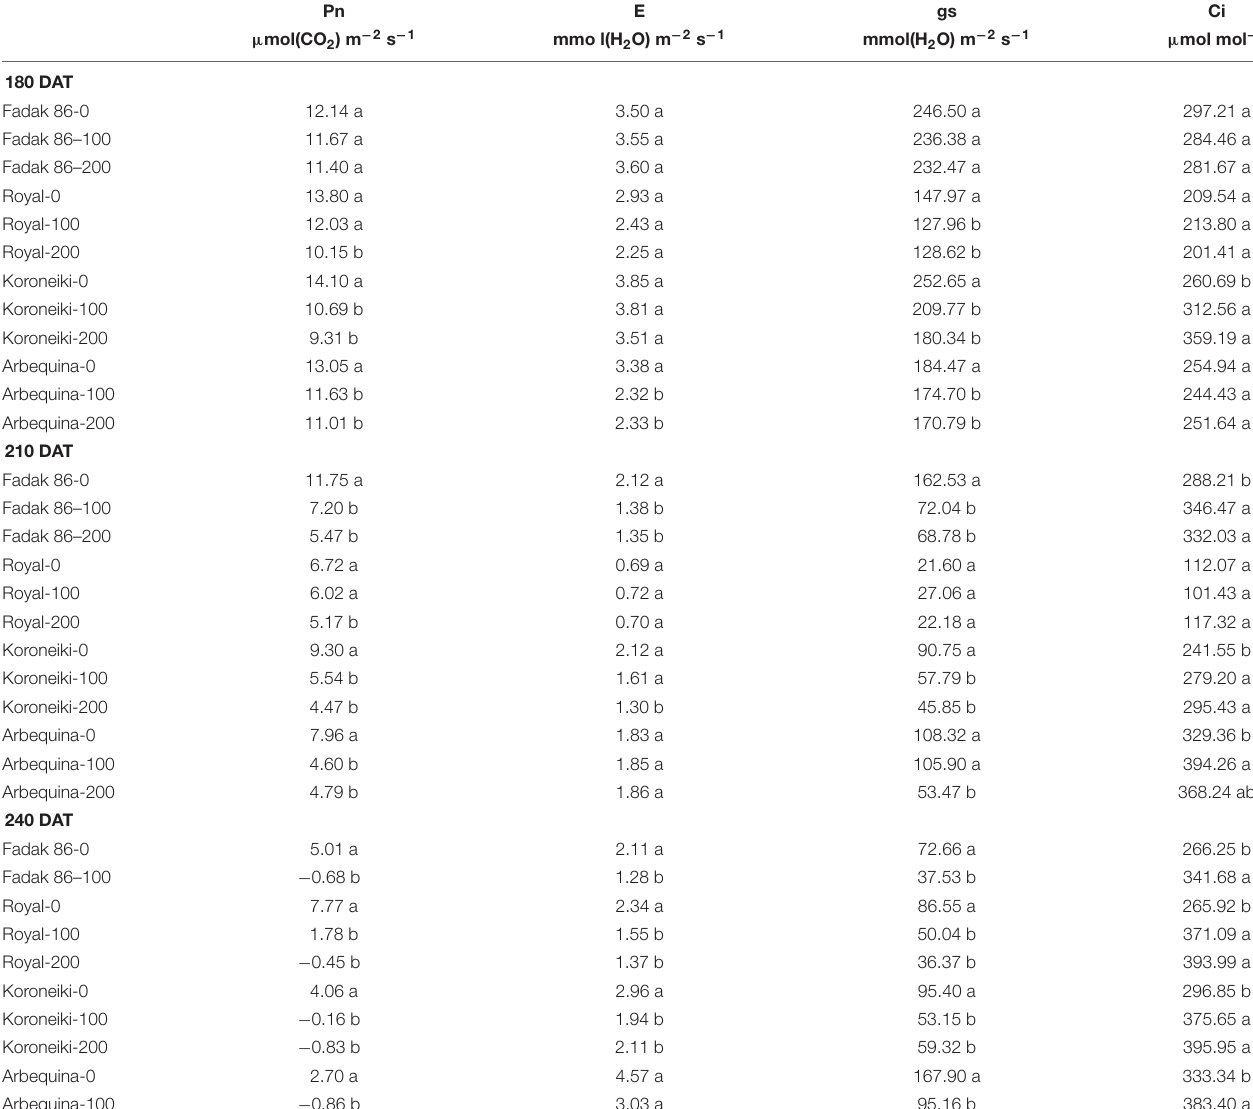
TABLE 1 | Gas exchanges in four cultivars treated with 0, 100, and 200 mM